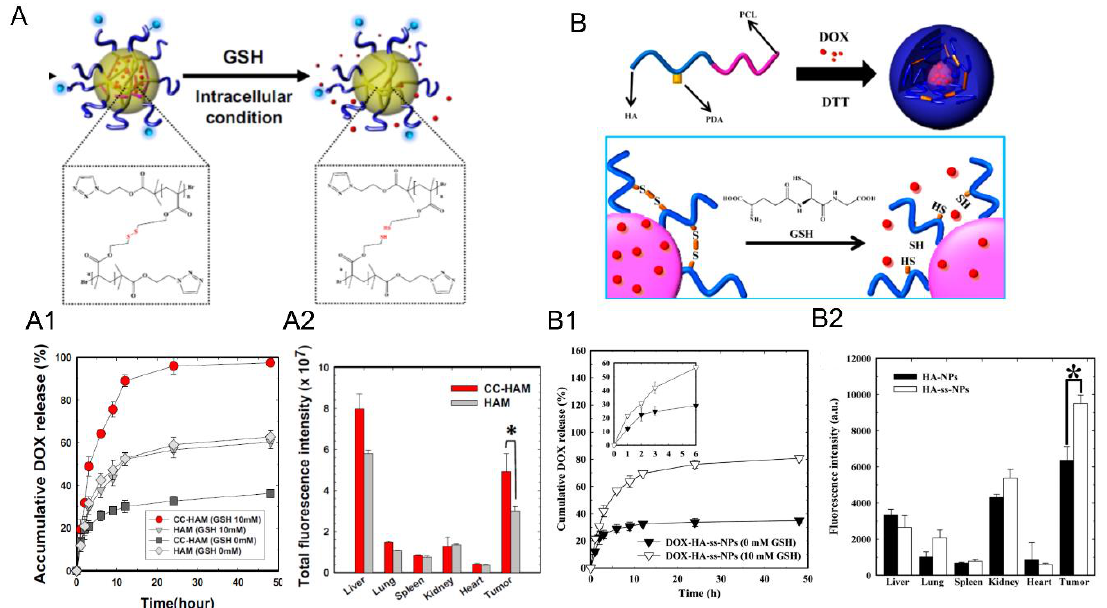
Figure 7. ( A ) Synthetic scheme of core crosslinked HA-b-poly(PDSMA) (CC-HAM) micelles loaded with DOX. ( A1 ) Release profiles of DOX from CC-HAMs and HA-b-poly(PDSMA) (HAM) in the absence or the presence of GSH. The error bars in the graph represent standard deviations ( n = 5). ( A2 ) Fluorescence intensity of tumors and organs. Asterisks (*) denote statistically significant di ff erences (* p < 0.05) calculated by one-way ANOVA test. ( B ) Synthetic scheme of the formation of DOX-loaded crosslinked micelles and their glutathione (GSH) responsive drug release behavior ( B1 ) In vitro release behavior of DOX from DOX-HA-ss-NPs in the absence or the presence of GSH. The error bars in the graph represent standard deviations ( n = 3). ( B2 ) Quantification of the ex vivo tumor-targeting characteristics of HA micelles in tumor bearing mice. Error bars in the graph represent the standard deviation for five animals per group. Adapted with permission from [34,37]. Copyright 2019, American Chemical Society and Elsevier, respectively.